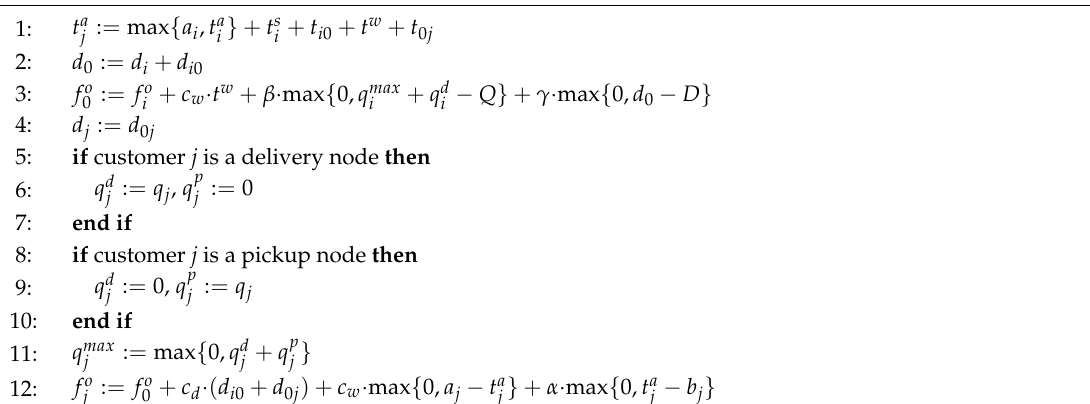
Algorithm 4: Extension rule considering depot between a pair of nodes.